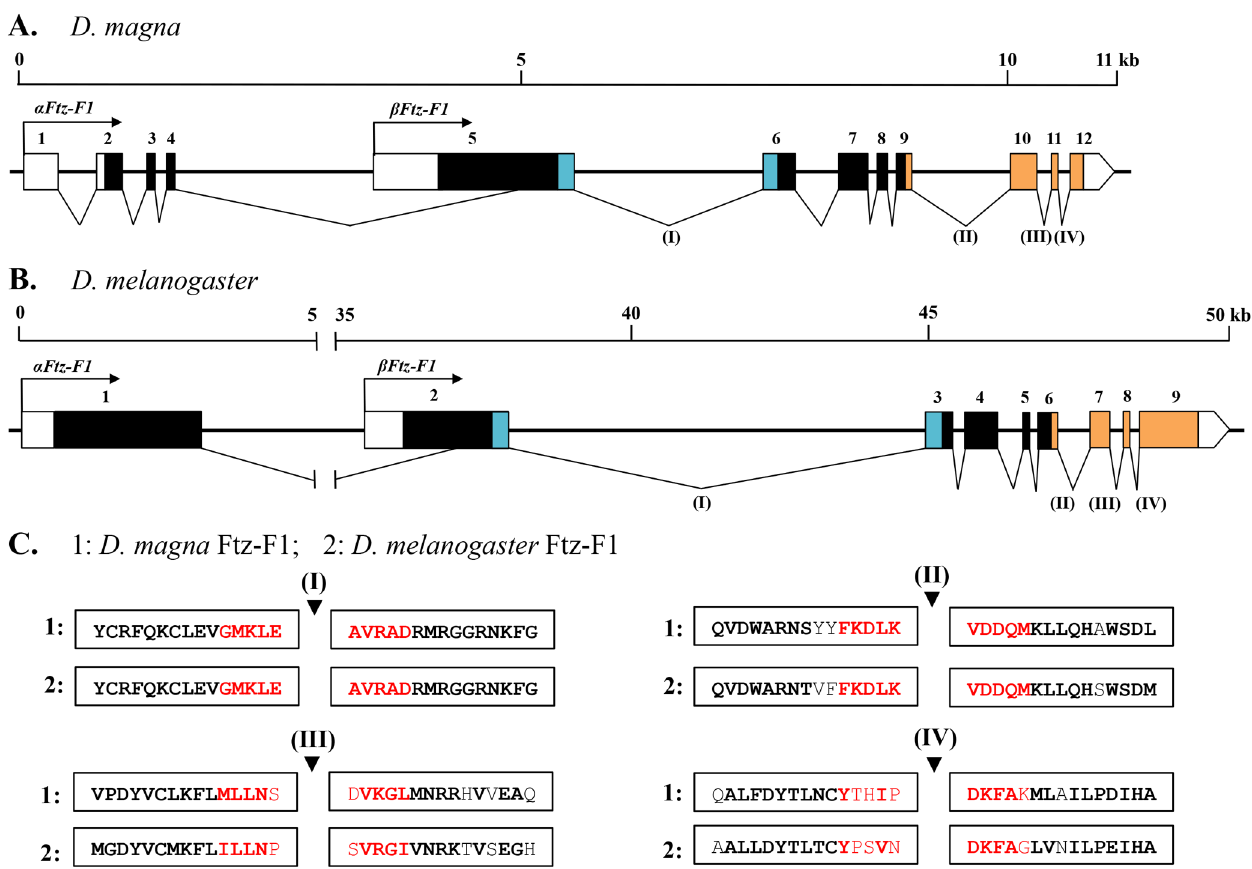
Fig 4. Genomic structural organization of (A) the D . magna Ftz-F1 gene and (B) the Dr . melanogaster Ftz-F1 gene. The numbered boxes are exons, and the intervening lines are introns. Colored boxes indicate coding regions; blue represents DBD, whereas orange represents LBD. Empty boxes indicate untranslated regions. Each isoform possesses a unique coding sequence at the 5 0 end, with black arrows indicating the transcription start site. Scale bars are provided at the top of each diagram for the size in kilobases. Numbers I, II, III, and IV indicate the location of intron splice sites that are conserved between D . magna and Dr . melanogaster . (C) Putative conserved splice sites mapped to the conserved domain of Ftz-F1 from (1) D . magna and (2) Dr . melanogaster . The amino acid sequences shown are from DBD (Number I) and LBD (Numbers II, III, and IV). Red amino acids indicate 10 residues (five residues for pre- and post-introns, respectively) around the intron position assigned as the splice site, whereas further homology up and downstream of the intron is represented in black. Bold amino acid residues are residues shared between two species. Black triangles indicate the location of the intron within the splice